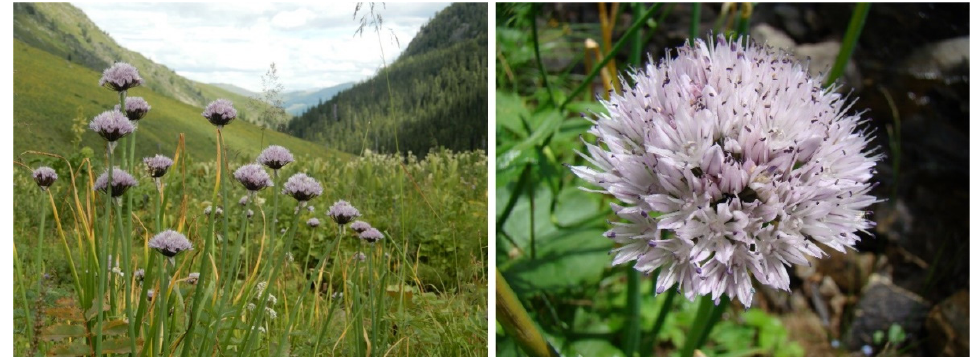
Figure 2. Plants of A. ledebourianum (flowering 14 July 2020, Southern Altai) (photo by I. Satekov). The ecological conditions of the A. ledebourianum populations in the Kazakhstan Altai territory are presented in Table 3. Table 3. Characteristics of A. ledebourianum plants from natural populations in Kazakhstan Altai.